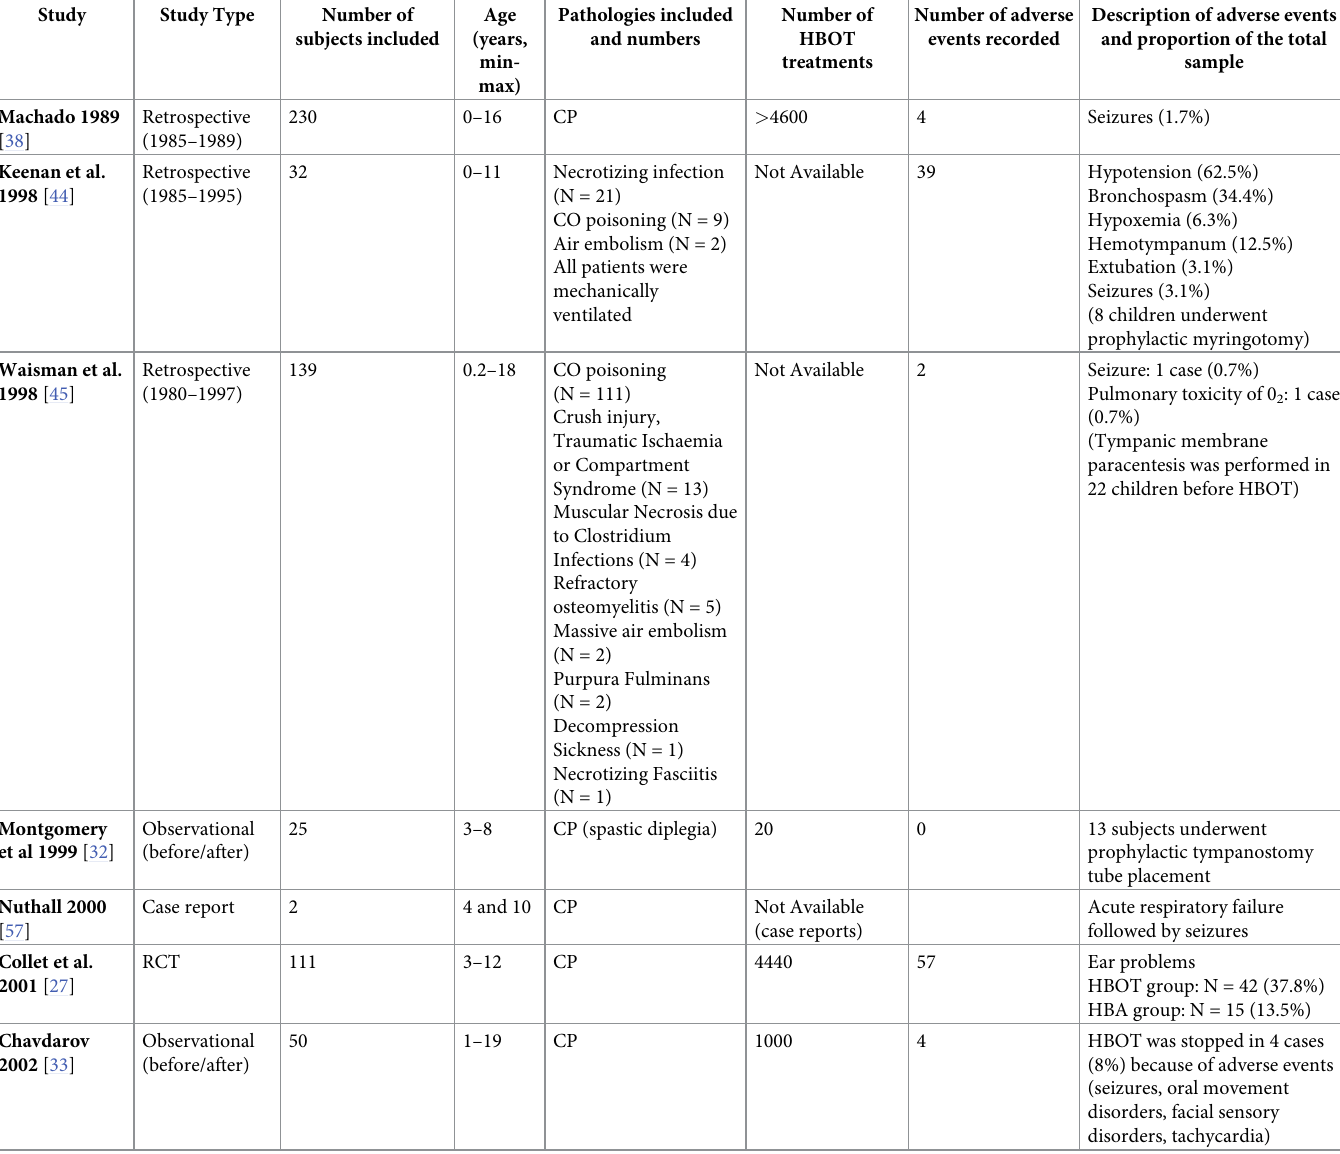
Table 2. Adverse events recorded in the